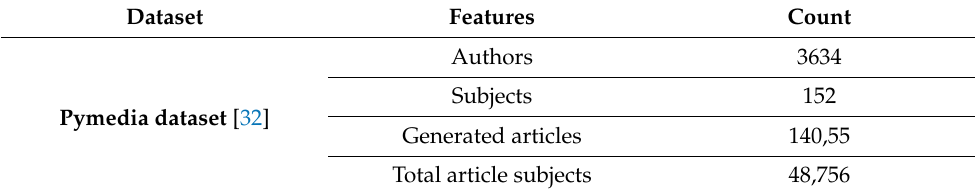
Table 2. Pymedia dataset